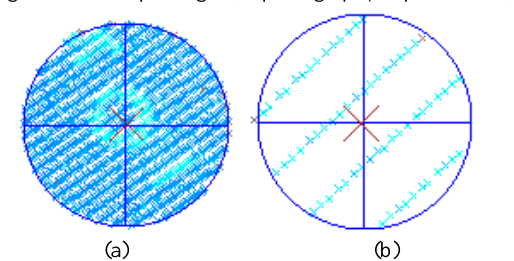
Figure 10. Example target (L: photograph, R: point cloud)